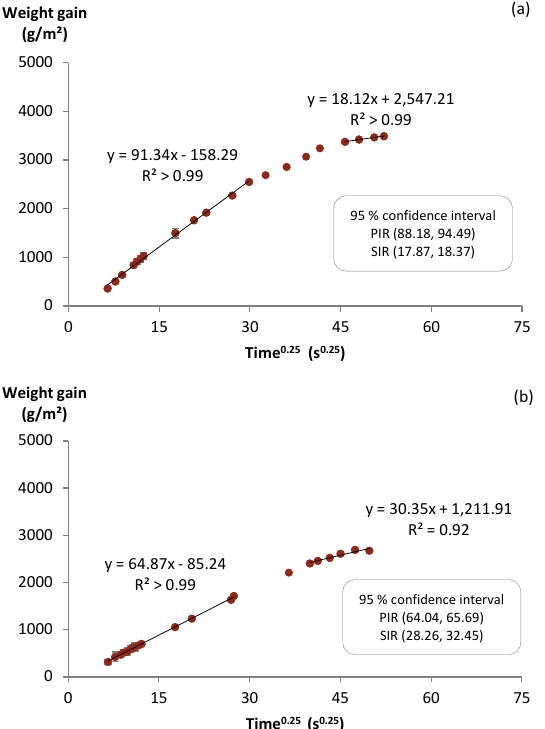
Figure 5. Capillary imbibition rate of Mix 4 at 28 (a) and 91 (b) days of age. The 95 % confidence intervals of the corresponding PIR and the SIR are given between parenthesis.